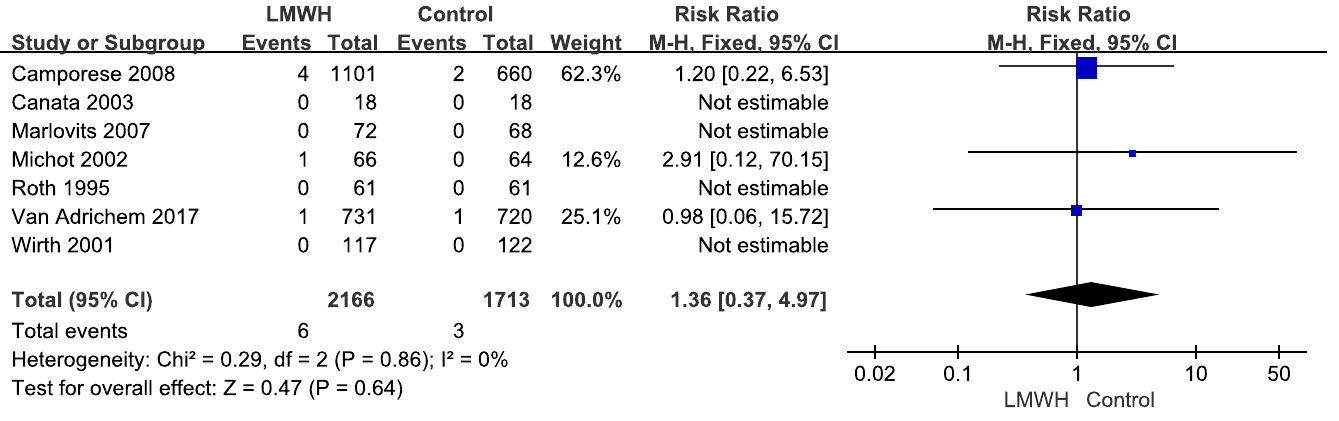
Fig 6. LMWH versus control. Symptomatic pulmonary embolism during follow-up.